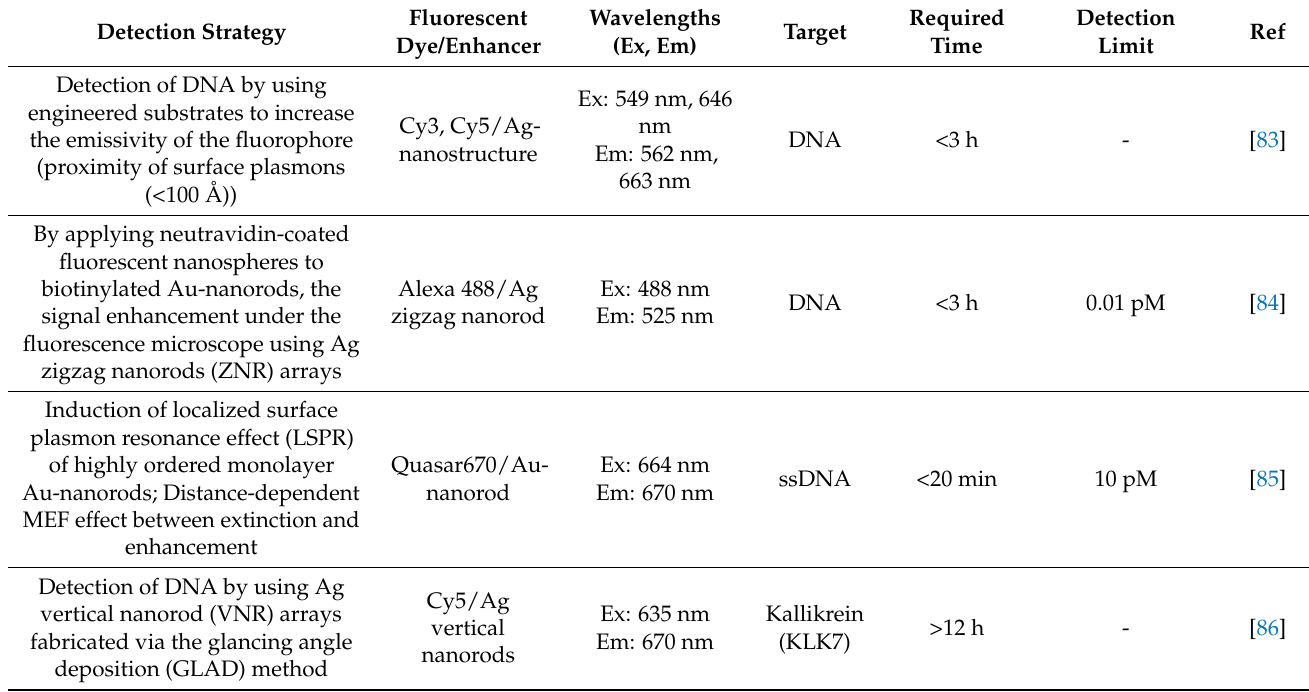
Table 2. Comparison of MEF-based nanobiosensors for nucleic acid